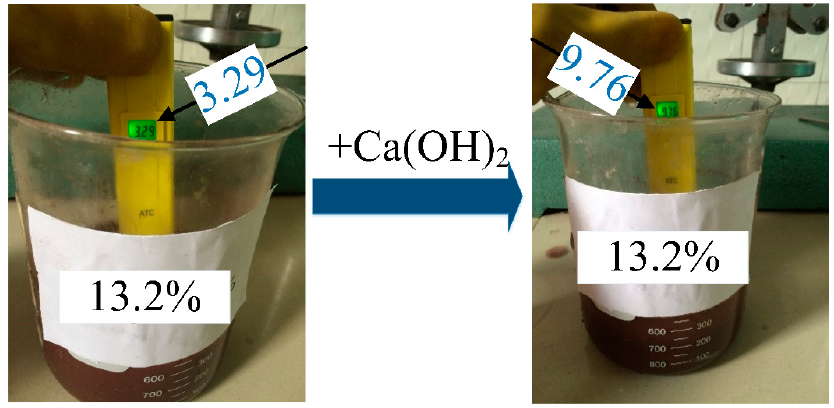
Figure 5. Neutralization reaction of leaching residue.